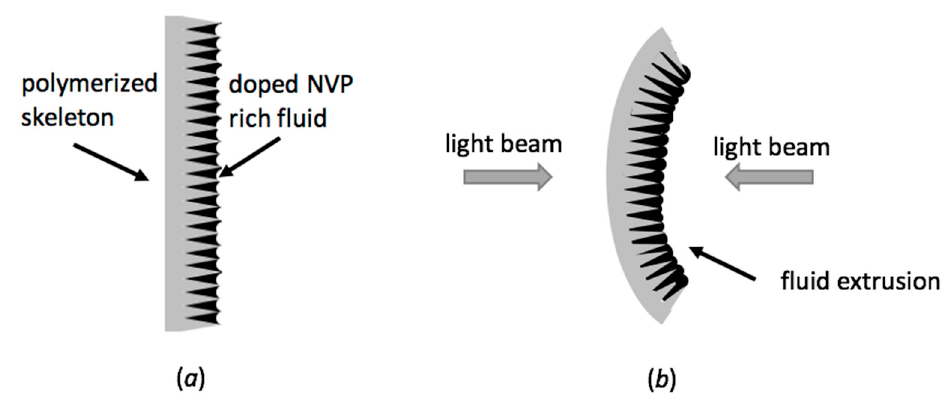
Figure 1. Sketch of the working mechanism of photomobile polymer (PMP) based on di-pentaerythritol-penta/hexa-acrylate (DPEPA)-co-NVP (1-vinyl-2-pyrrolidinone) film: ( a ) before light irradiation; ( b ) under light irradiation (from either side of the film).